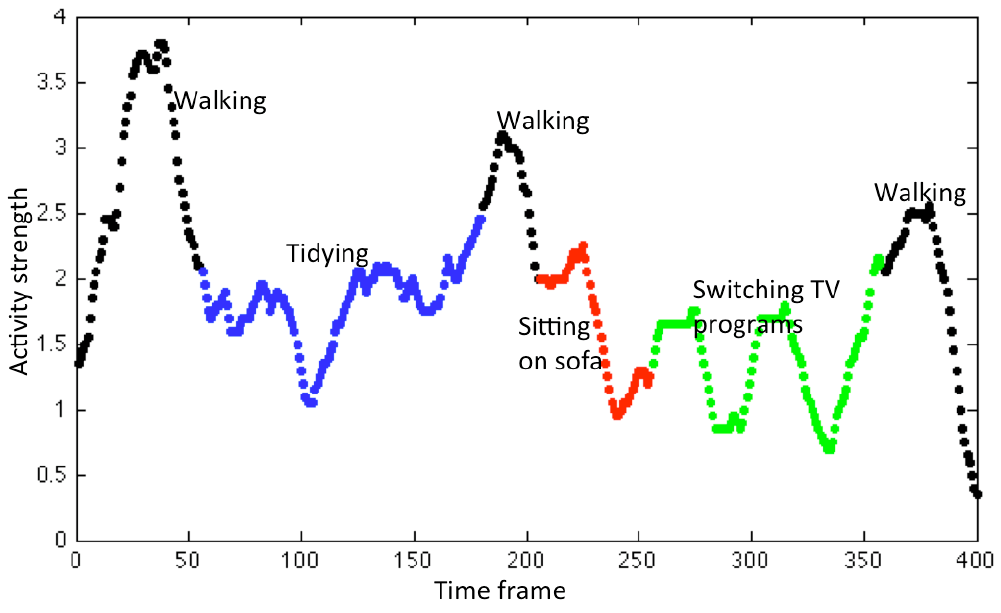
Figure 5. Activity strength (the sum of the 20 pixel values) of a series of activities in the home environment. Different colors show different